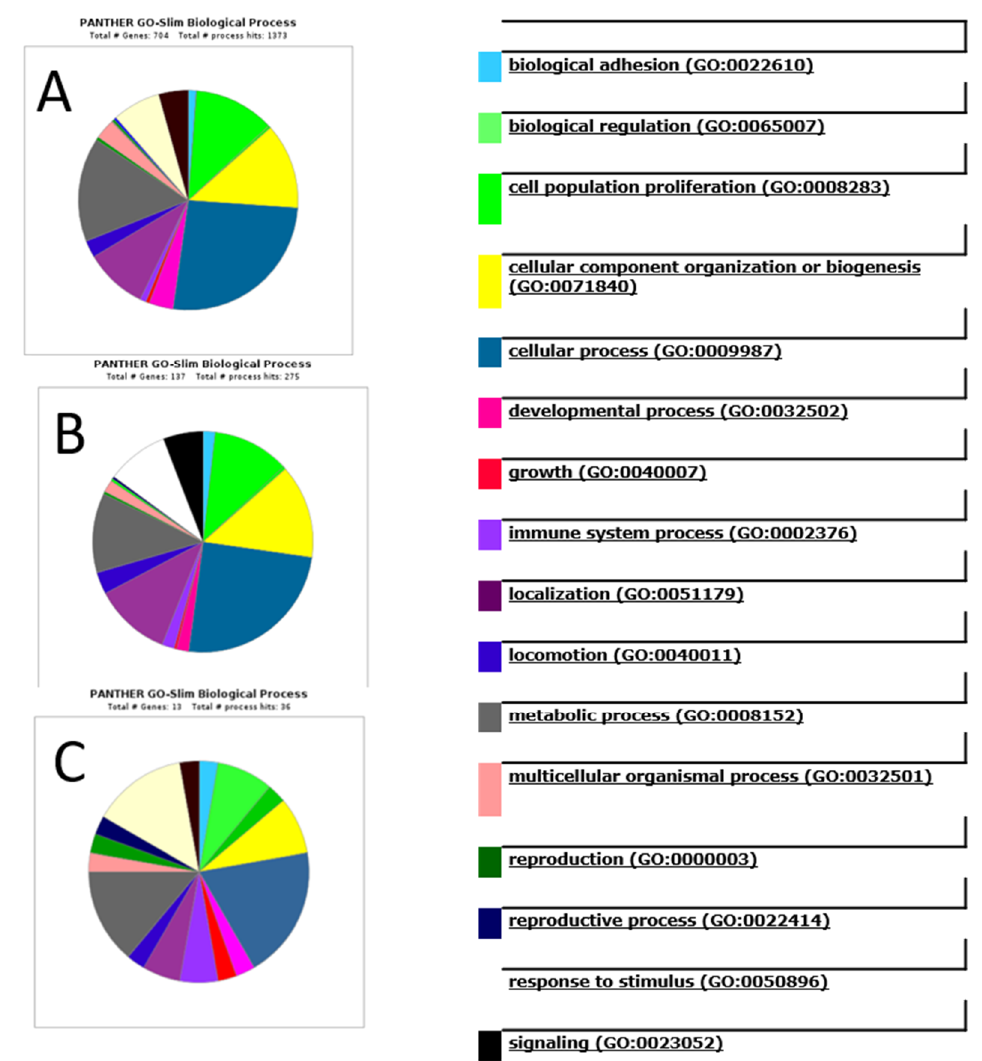
Figure 8. Analysis of the involvement of the detected proteins in biological processes using PANTHER software. ( A ) all the detected exosomes proteins; ( B ) the common exosomes proteins. ( C ) the potential glioblastoma biomarkers (ANXA1, ANXA2, ENOA, G3P, HS90B, KPYM, PRDX1, TPIS, TERA, VIME, 1433E, COF1, NPM) detected in exosome samples.